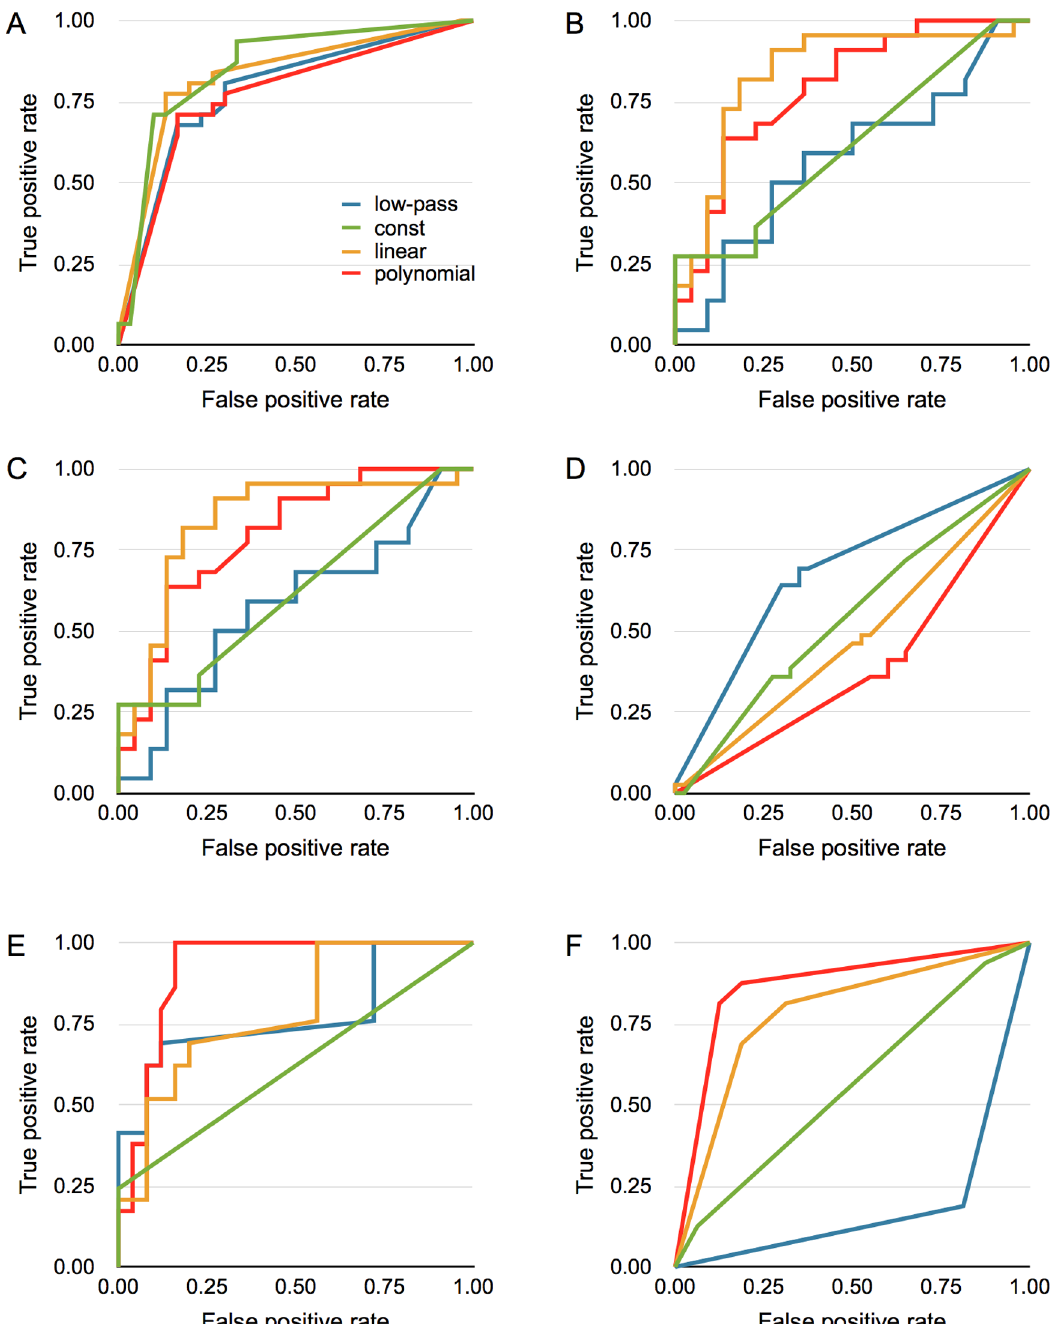
Fig 6. ROC curves for the different methods. The ROC curve for each method and data set indicates who well the differences in response magnitude could be used to distinguish between the two stimulus types described in Table 1.